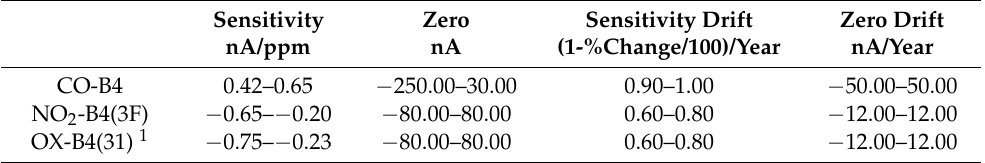
Table 1. Properties of the electrochemical gas sensors. Sensitivity nA/ppm